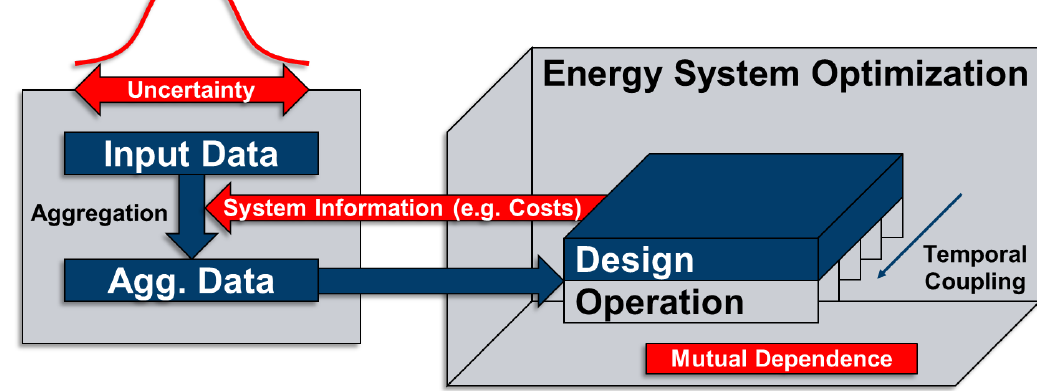
Figure 13. Mutual dependencies in aggregated energy system optimizations that necessitate feedback loops.